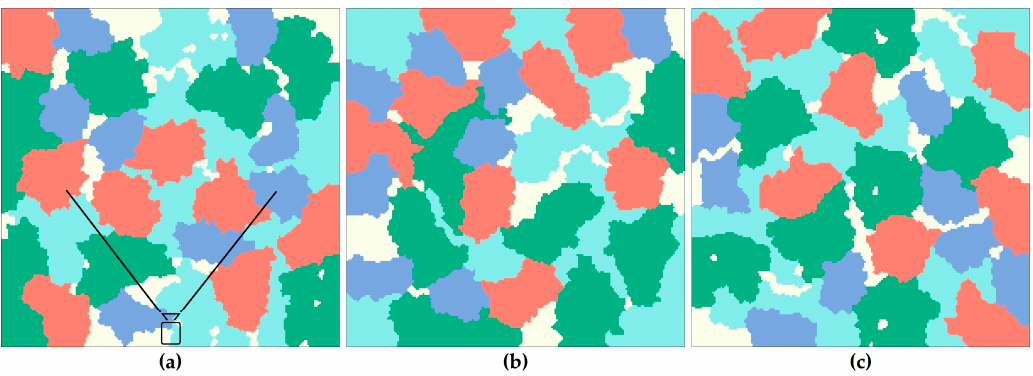
Figure 8. ( a ), ( b ) and ( c ) are three forest landscape instances generated by the proposed NLM that have similar spatial patterns to the study area. Each instance has 100 × 100 cells and each cell represents a 25 m × 25 m square. Table 2. A comparison between the target values and actual values of the landscape metrics for each tree species. Tree Species Spruce